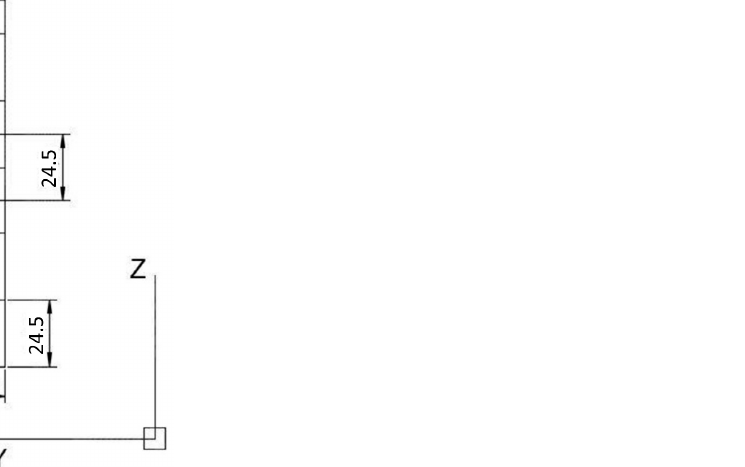
Figure 7. Distribution of the fin area to each tube for a supply tube. Measures are reported in cm. The air flows through the heat exchanger along the y-direction. The supply tubes are arranged along the z-direction.